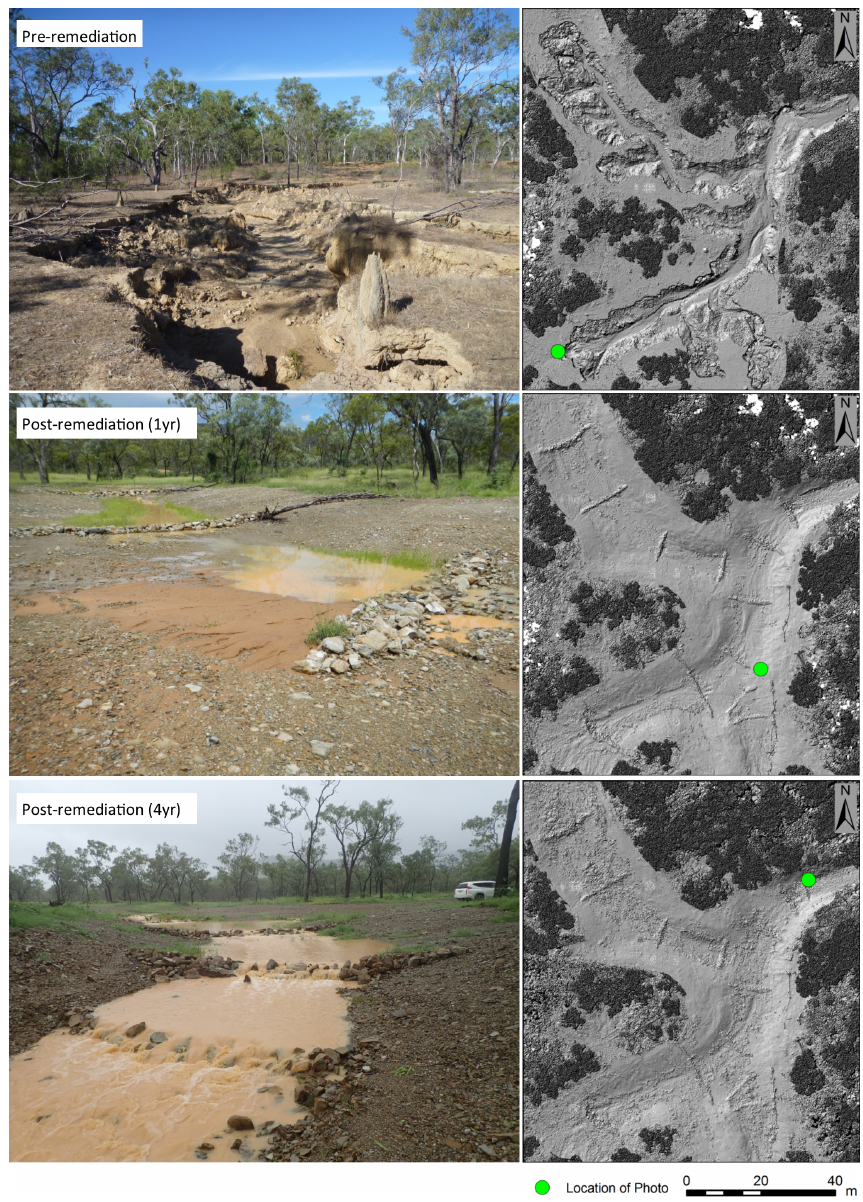
Figure 2. Before and after photos (left column) of the remediated gully and repeat lidar images (right column) of the remediated gully for the years 2016 (unremediated), 2017 (post-remediation – 1 year), and 2019 (post-remediation – 4 years). Note the aggradation of sediment in the gully. Green dots show the locations of the photographs. The information in this figure has been modified from Brooks et al.